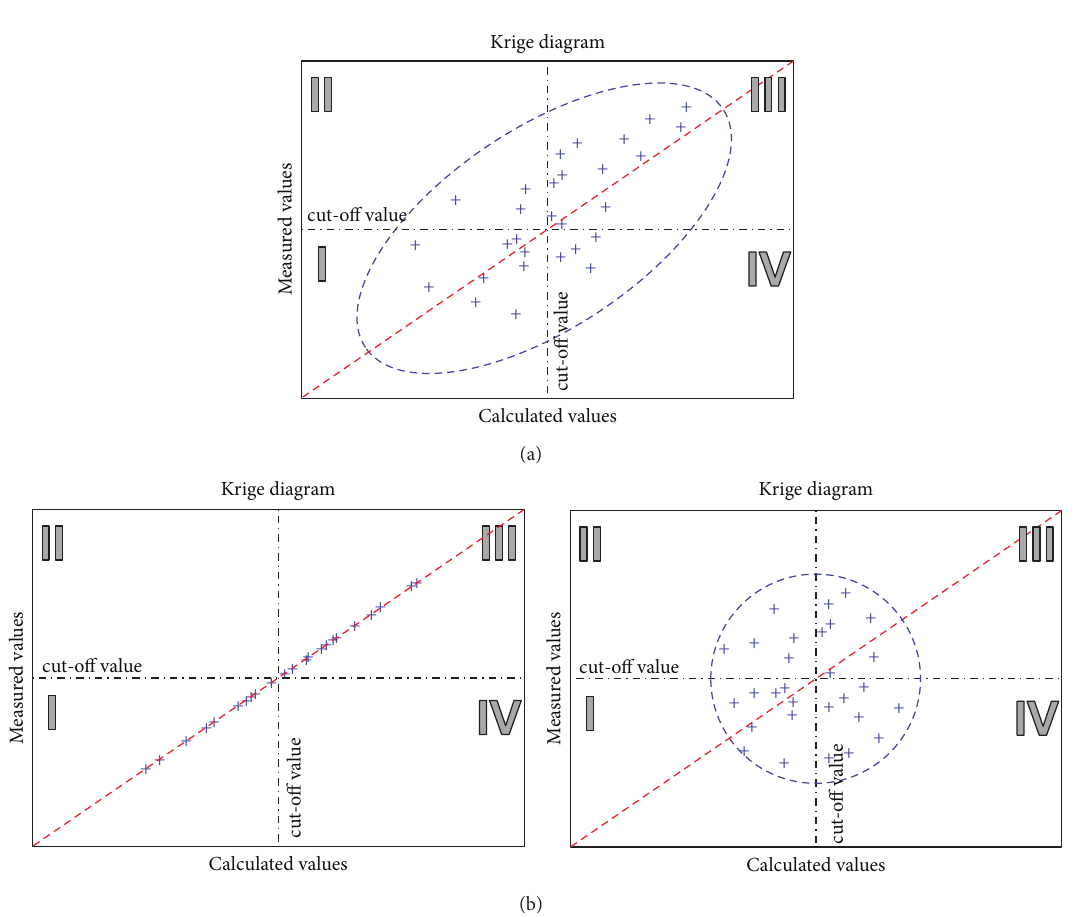
Figure 8: (a) Krige diagram representation in a typical condition; (b) comparison between correct and incorrect estimation process results.